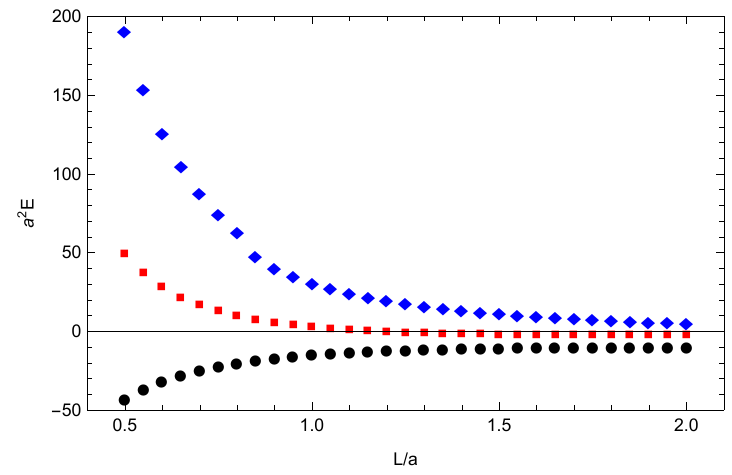
Figure 6 . The dependence of the energy levels on the box size for a (cid:12)xed value (cid:3) a = 225. The levels both below and above the three-particle threshold are considered. The behavior of the subthreshold level agrees well with the result of ref.